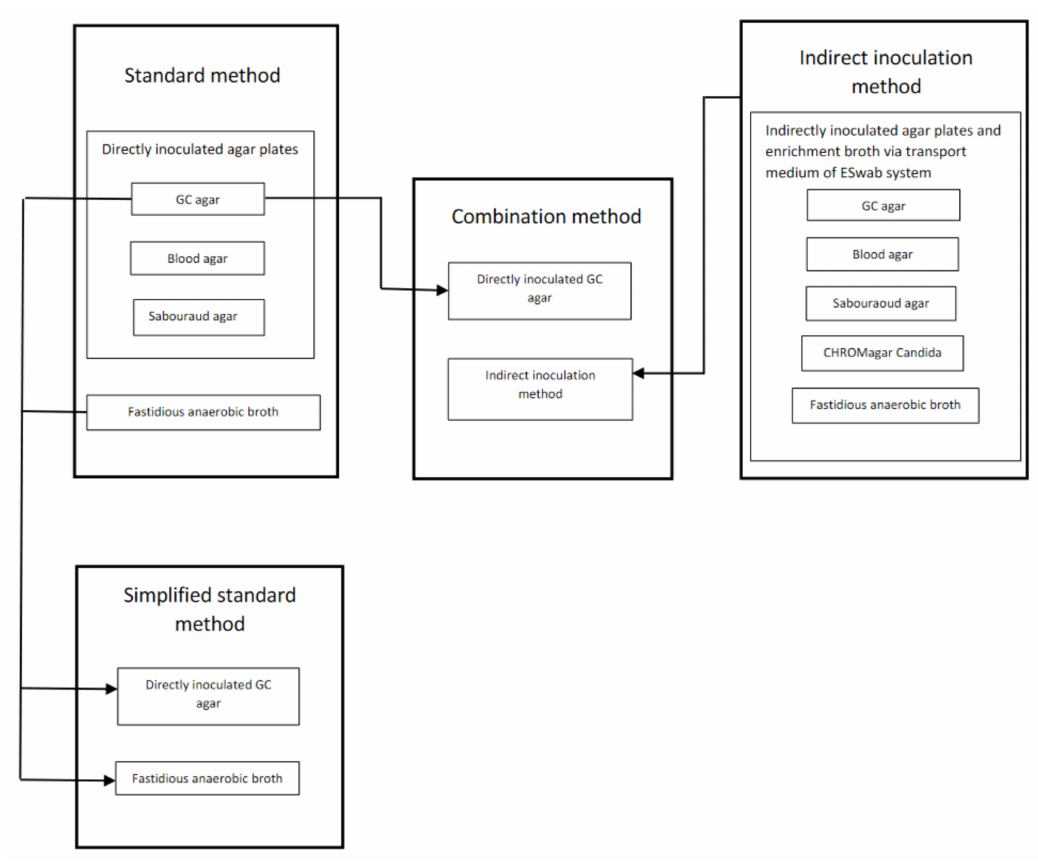
Figure 1. Direct and indirect inoculation approaches and culture media used in four different methods of corneal culture in patients with infectious